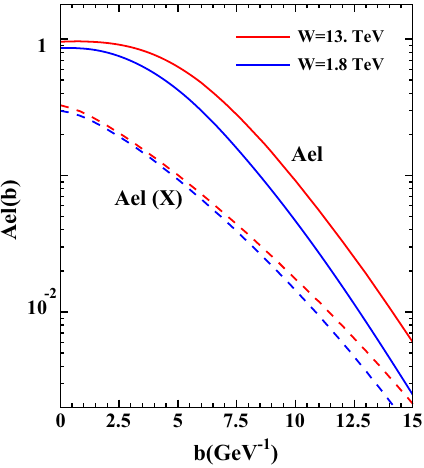
Fig. 3 The elastic scattering amplitude versus b . A el ( X ) is the ampli- tude from the Balitsky–Kovchegov equation( see Eq.